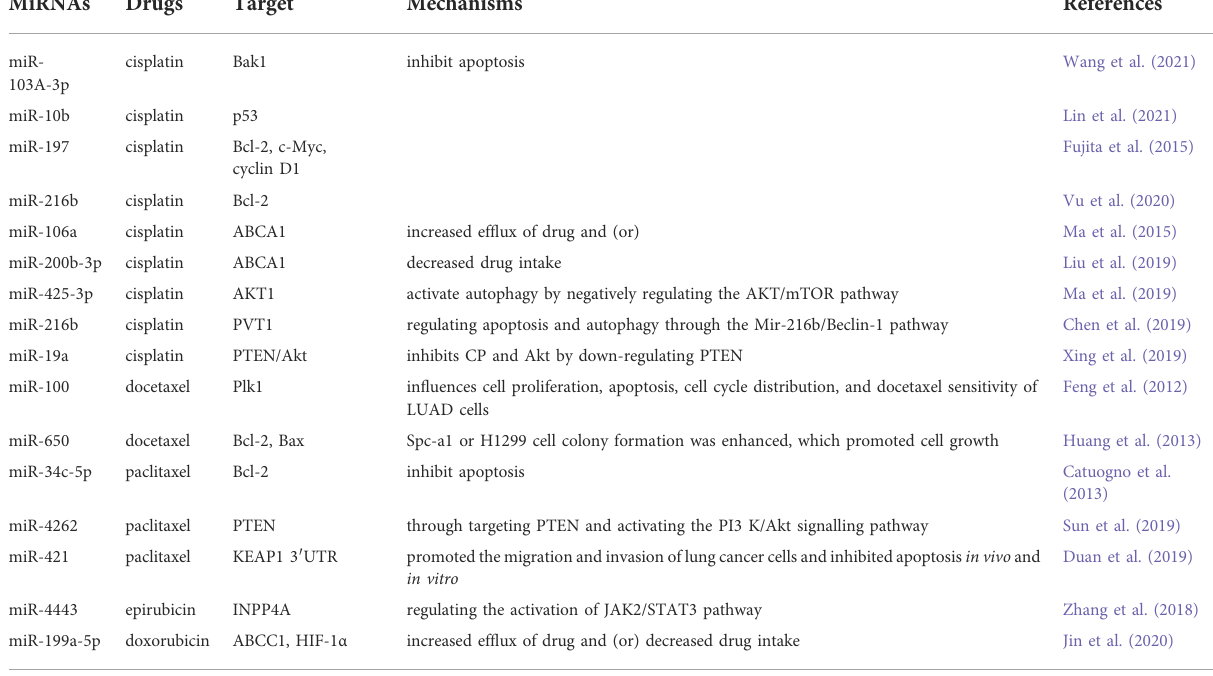
TABLE 1 Summary of miRNAs involved in drug resistance in chemotherapy of